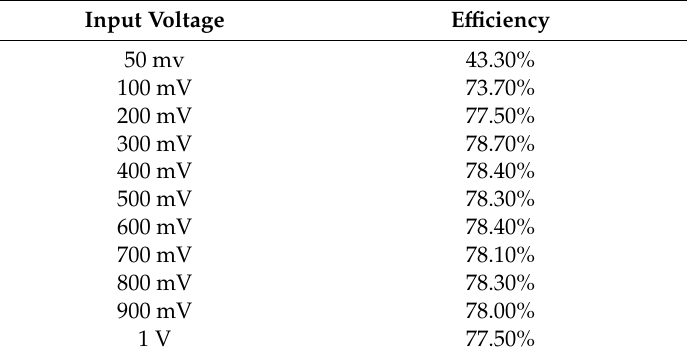
Table 3. Power e ffi ciency of the proposed